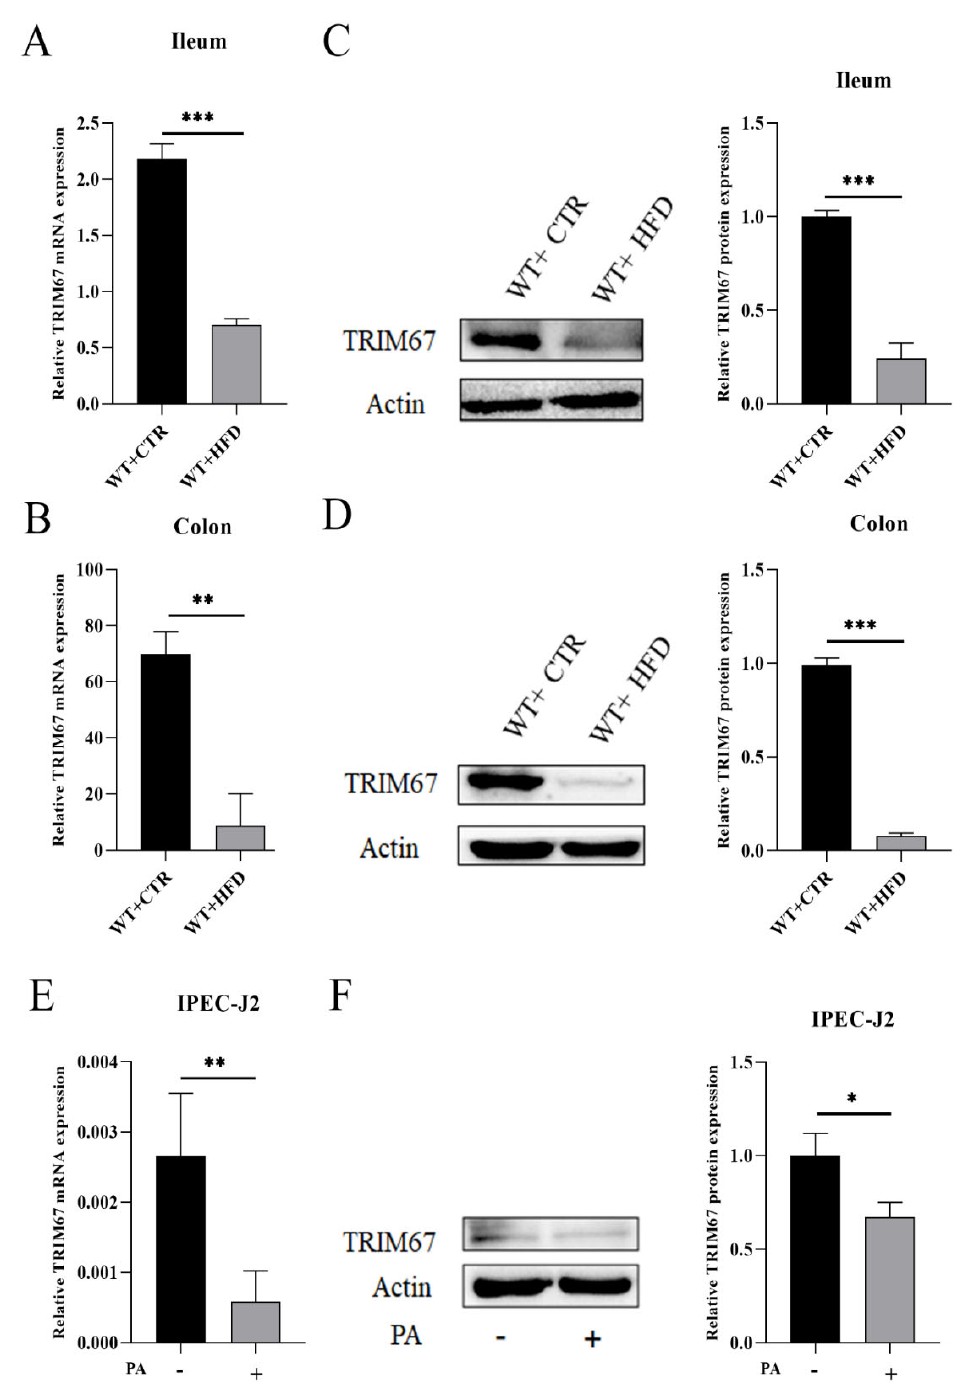
Figure 1. Effect of HFD on the expression of TRIM67 in WT mice. ( A , B ) Relative mRNA expression of TRIM67 in ileum and colon ( n = 4). ( C , D ) WB and quantification of TRIM67 in ileum and colon of WT CTR and WT HFD groups ( n = 4). ( E ) IPEC-J2 cells were supplemented with PA to develop an obesity model in vitro and relative mRNA expression of TRIM67 in PA supplemented group ( n = 3). ( F ) WB results and quantification of protein expression of TRIM67 in PA supplemented IPEC-J2 cell lines, “-”: no addition, “+”: addition ( n = 3). The data are expressed as mean ± SEM. Significance was determined by two-tailed Student’s t test (* p < 0.05, ** p < 0.01, *** p < 0.001).